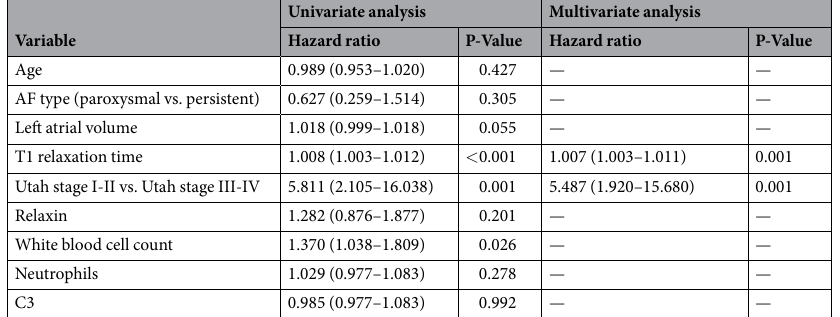
Table 3. Predictors of freedom from recurrent atrial arrhythmia. Predictors of freedom from recurrent arrhythmia after ablation therapy were determined by using Cox regression. Significant univariate predictors were entered into the multivariate model. Hazard ratios are given with 95% confidence interval. AF = atrial